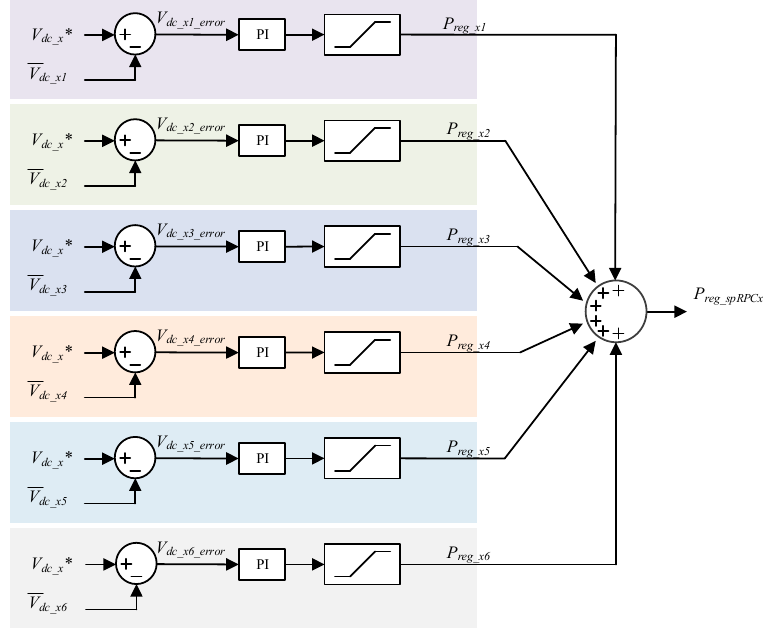
Figure 7. Block diagram of the control algorithm responsible for regulating the different dc-link voltages on the spRPCx .